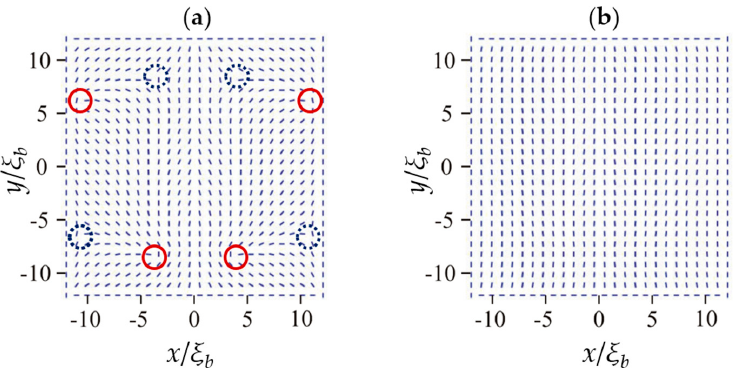
Figure 7. Annihilation by increasing an external in-plane electric field. Selected qualitatively different director profiles are shown. (𝐚) 𝜇 (cid:3033) = 0.7,(𝐛) 𝜇 (cid:3033) = 3.5. 𝑅/𝜉 (cid:3029) = 25 , 𝑡 = −8 . TDs bearing m =1/2 and m =-1/2 are indicated by red and blue circles, respectively.